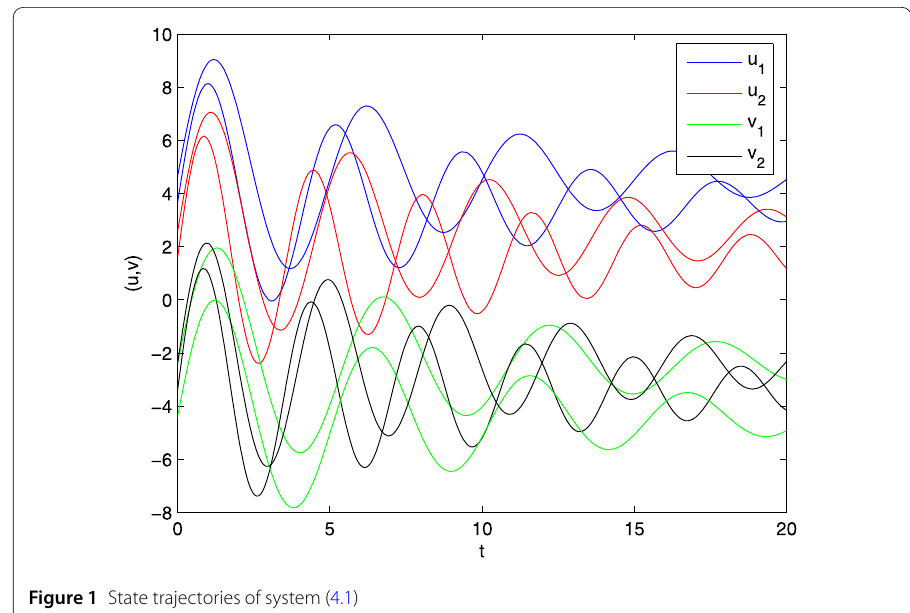
Figure 1 State trajectories of system